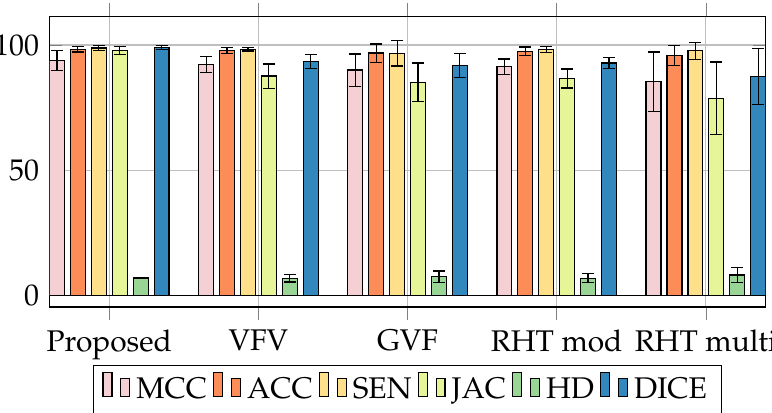
Figure 10. Illustration between metric values obtained compares the proposed method to other methods in the literature presented in Table